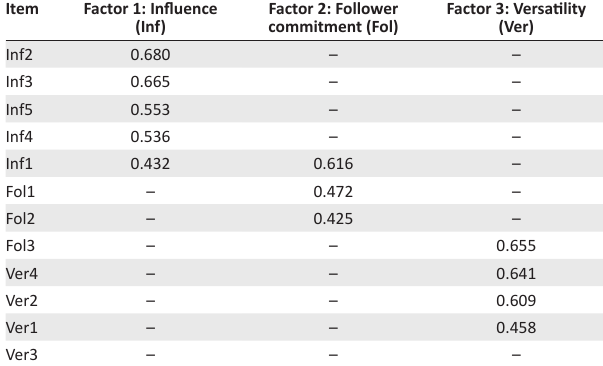
TABLE 5: Results of factor analysis for leadership effectiveness.